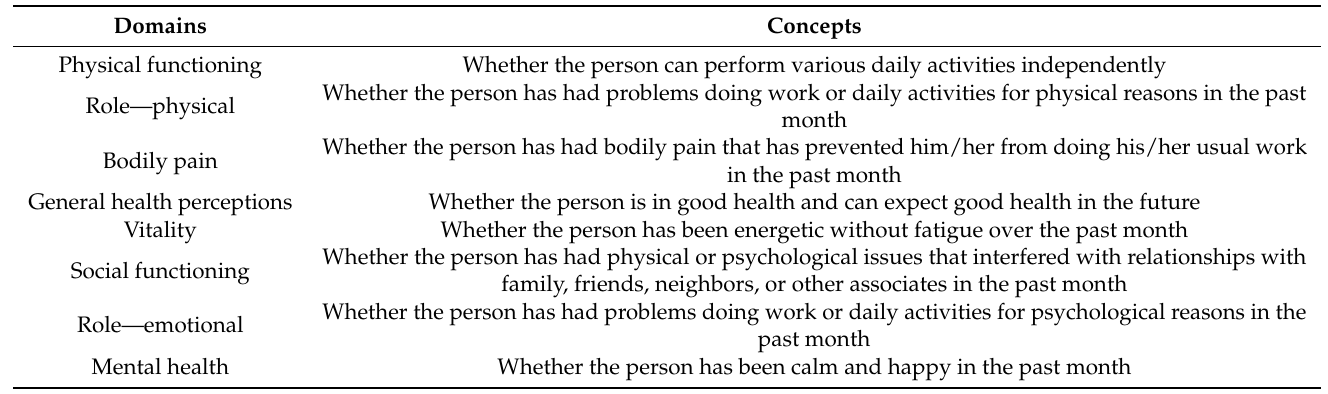
Table 1. Concepts of the eight health dimensions of